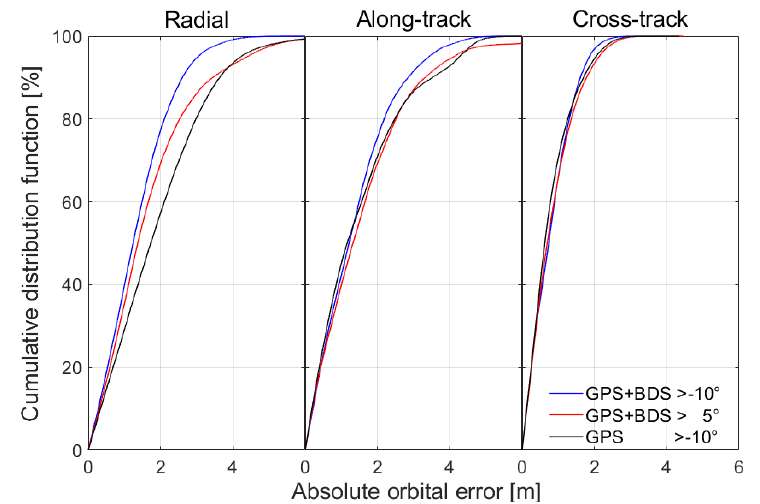
Figure 11. Cumulative distribution function of absolute orbital error in the radial, along-track, and cross-track directions. Table 2. Performance statistics of the positioning accuracy. Scheme